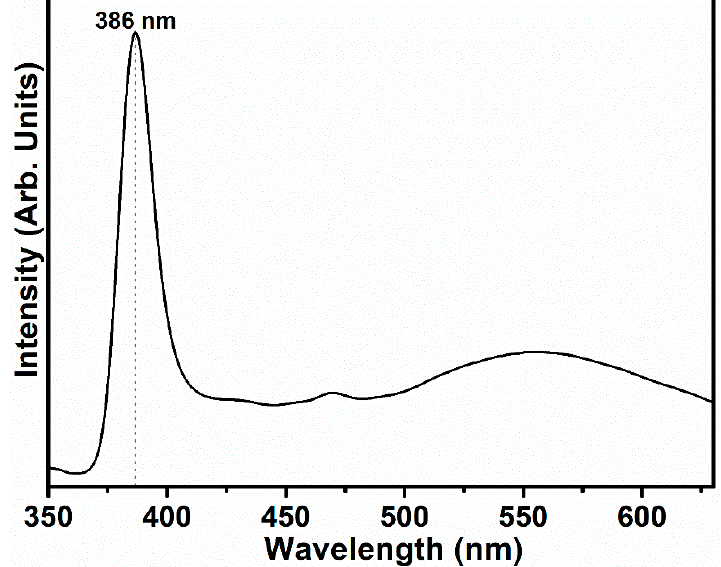
Figure 3. Room temperature PL spectrum of flower-shaped ZnO nanostructures directly grown on FTO substrate.